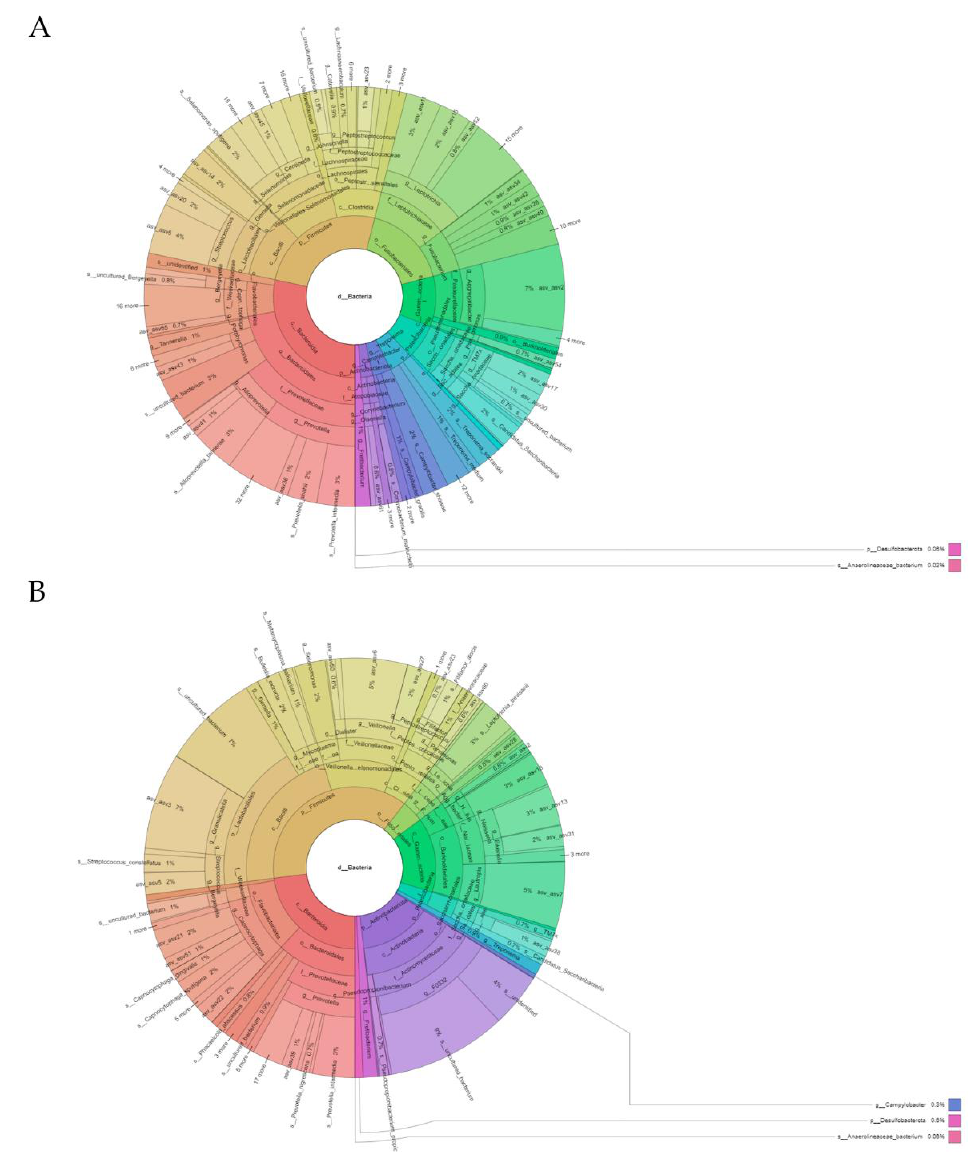
Figure 4. Representation created using the Krona hierarchical browser of the phylotypes identified at the phylum, class, order, family, genus, and species level in an individual with periodontitis: ( A ) Baseline subgingival sample; ( B ) Subgingival sample compatible with gingival health after antibiotic therapy.